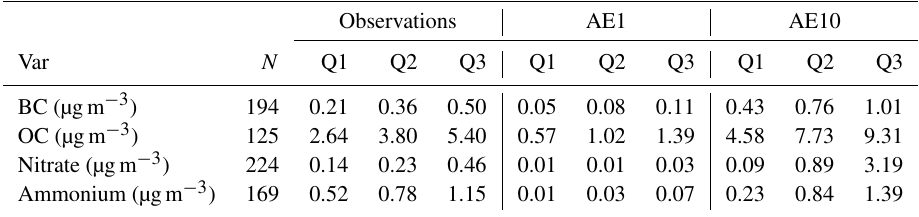
Table 2. Distribution of observed and modeled aerosol concentrations (in µgm − 3 ) given by first quartile (Q1), median (Q2) and third quartile (Q3) of black carbon (BC), organic carbon (OC), ammonium, and nitrate below 2kma.m.s.l. (and above 300ma.m.s.l. to avoid airport areas) using all flights of the DACCIWA campaign during the period 1–7 July 2016. N is the number of samples for the comparison between observations and